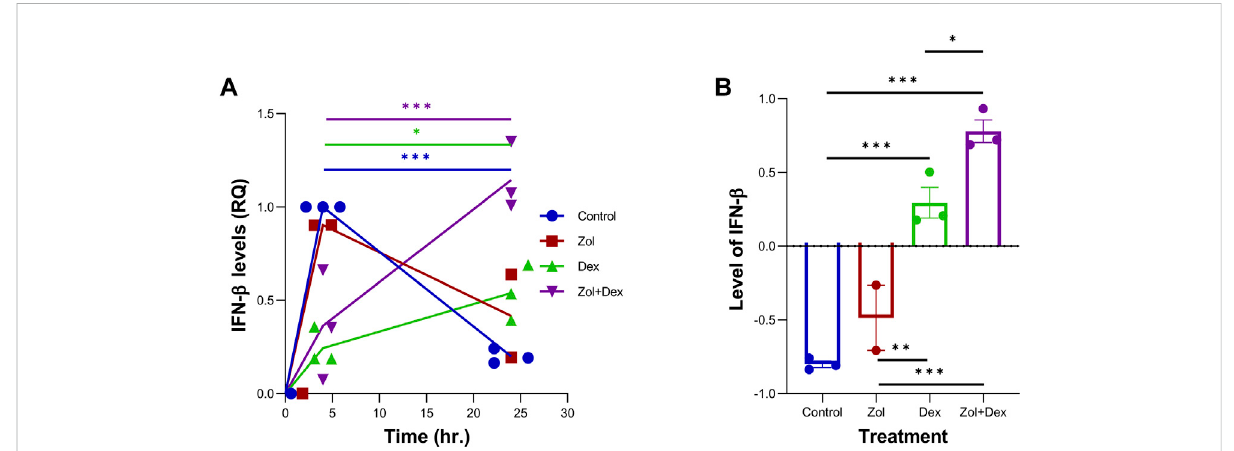
FIGURE 5 Zol+Dex increases IFN- β transcripts in peritoneal macrophages at 24 h. Male C57BL/6 mice were injected intraperitoneally with zymosan A (1 mg/mouse). After 66 h, the peritoneal exudates were collected, and peritoneal macrophages were isolated. Resolution phase peritoneal macrophages were collected and used immediately (time 0) or incubated for 4 or 24 h with Zol, Dex, or Zol+Dex, 10 µM each. R.N.A. was isolated from the samples, and RT-PCR for IFN- β was performed (A) Quantitative analysis of RT-PCR assay of IFN- β transcripts, comparison between 4 and 24 h (B) Differences between 24 and 4 h of each treatment. Statistical signi fi cance by one-way ANOVA ( n = 9). * p < 0.05, ** p < 0.01, *** p <